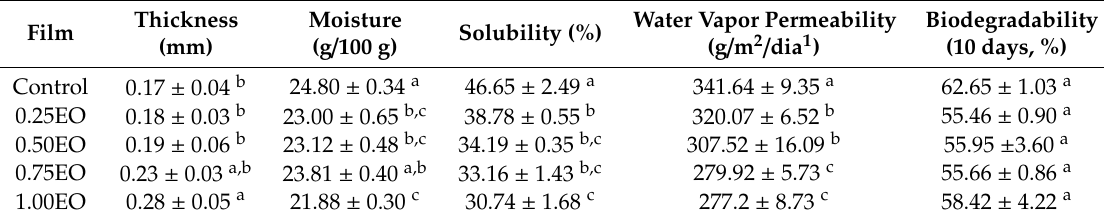
Table 2. Physical properties of chitosan films with Citrus limonia essential oil.